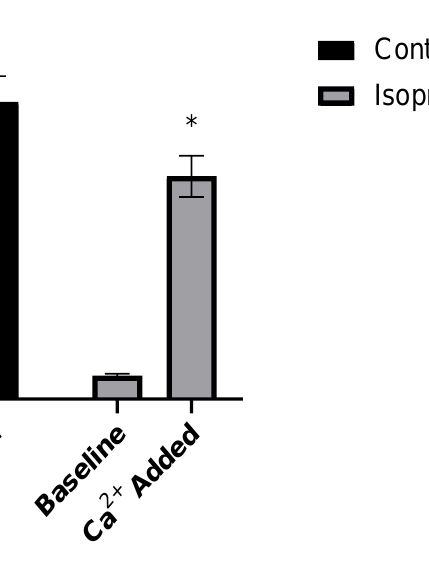
Figure 5. Isoprenaline-induced MPTP inhibition in hearts not exposed to I/R injury. Change in ab- sorbance of ( A ) adult or ( B ) P14 mitochondrial extract following addition of calcium to mitochondrial suspension with or without perfusion with isoprenaline. Baseline—peak change in OD at baseline; Ca 2+ Added—change in OD after calcium addition. * = p < 0.05 vs. baseline swelling in same group; data expressed as mean value ± standard error of the mean. Significance testing by ANOVA. n = 6 per group.